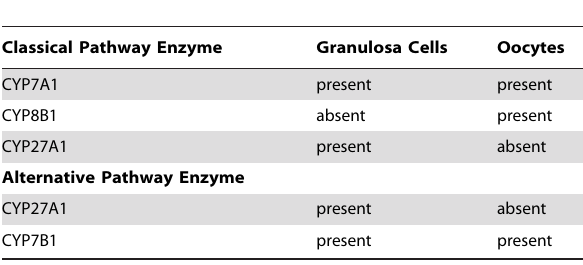
Table 1. Presence of bile acids synthesis enzymes in human ovarian